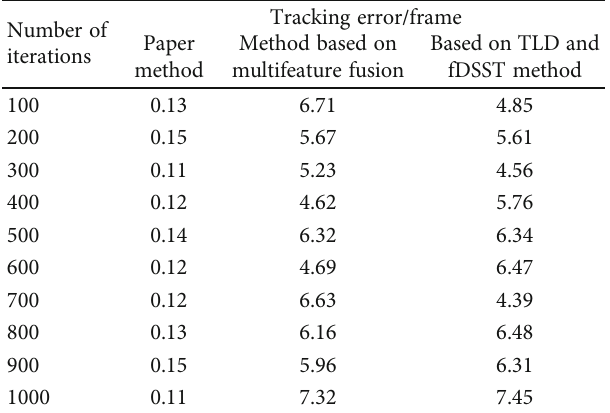
Table 1: Comparison of tracking errors. Number of